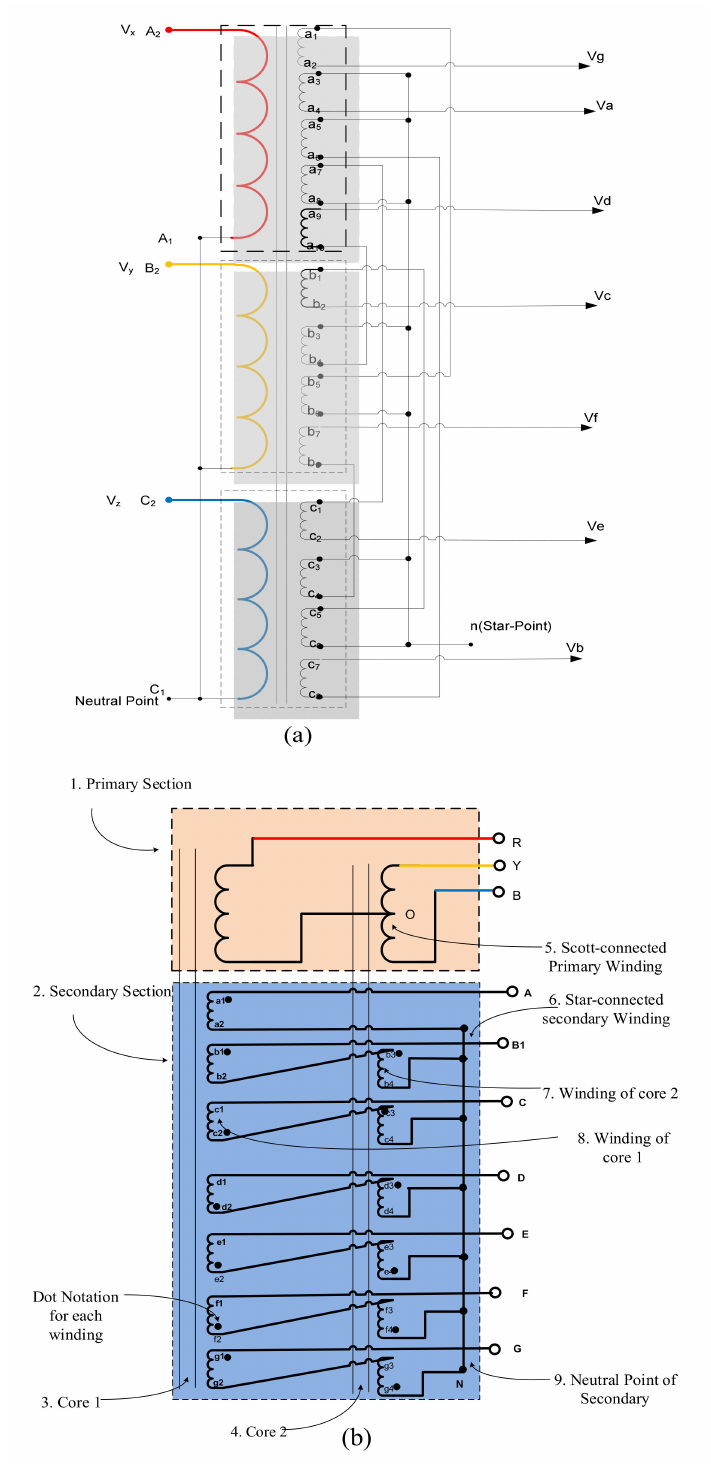
Figure 8. ( a ) Configuration 1 ( b ) Configuration 2 of the two alternative wiring diagrams for a three-phase to seven-phase transformer